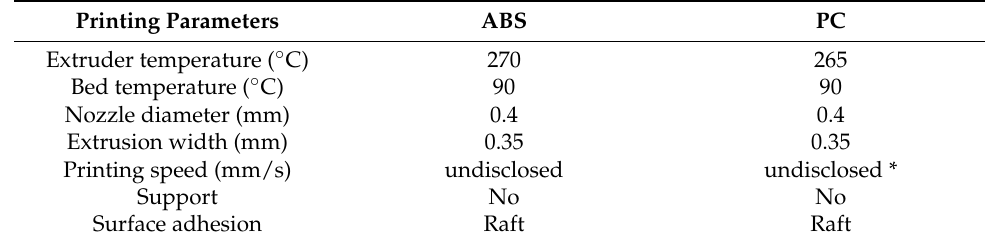
Table 4. Printing parameters used for the manufacturing of samples.